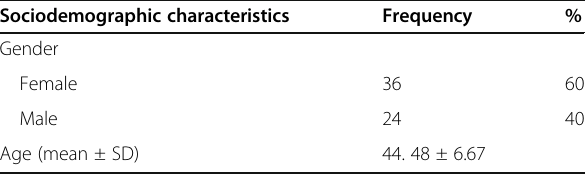
Table 1 Demographic data of the participants Sociodemographic characteristics